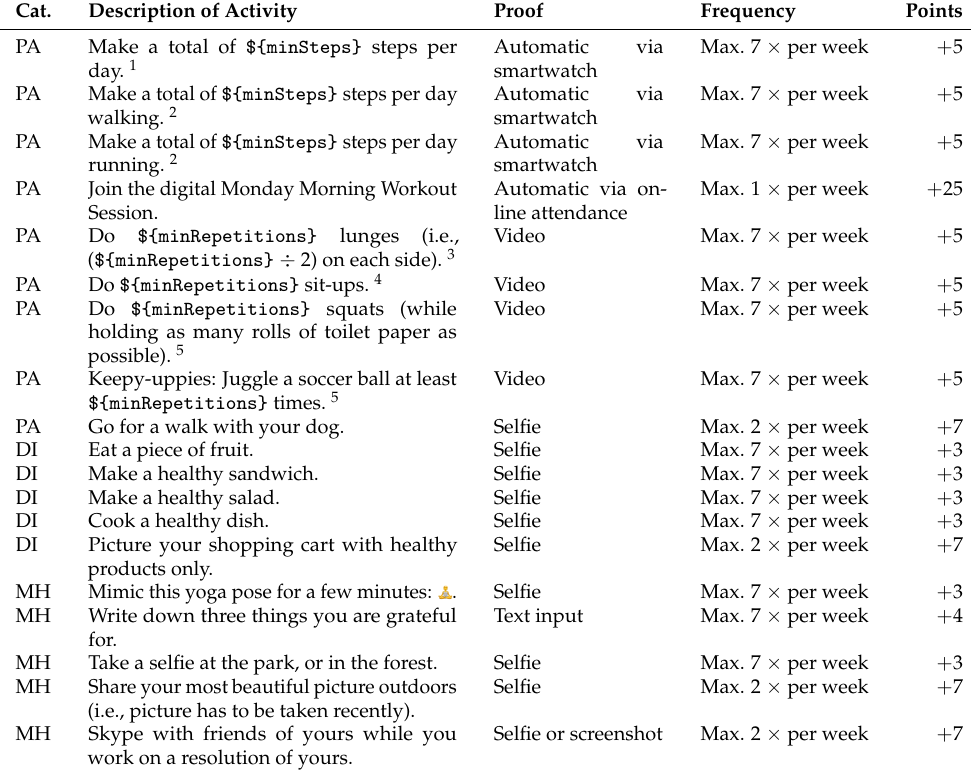
Table A1. List of activities that were suggested to participants. Cat. Description of